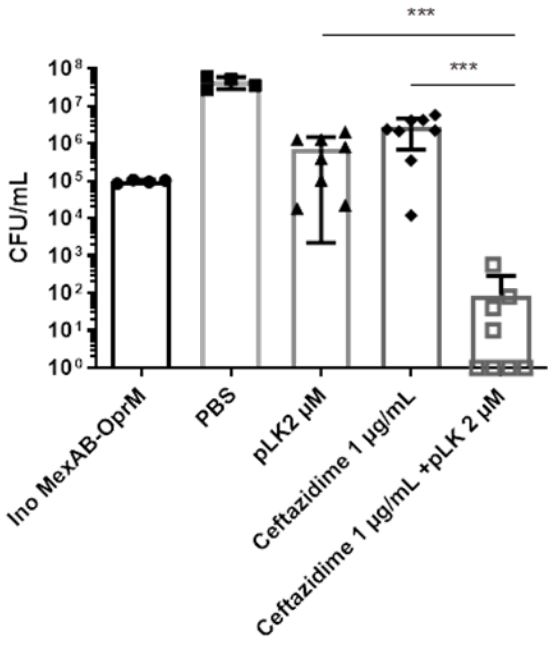
Figure 7. Ex vivo synergistic effect of the combination of pLK and ceftazidime against a ceftazidime- resistant P. aeruginosa strain. Human primary bronchial epithelial cells maintained in an air–liquid interface were infected with a MexAB-OprM clinical strain and treated one hour postinfection with either PBS, 2 µ M pLK, 1 µ g/mL ceftazidime or the combination of ceftazidime/pLK. Determination of the colony forming unit (CFU)/mL was evaluated after 24 h postinfection. Values are mean ± SEM of three independent experiments. Statistical analysis was performed using the Mann–Whitney test (*** p <